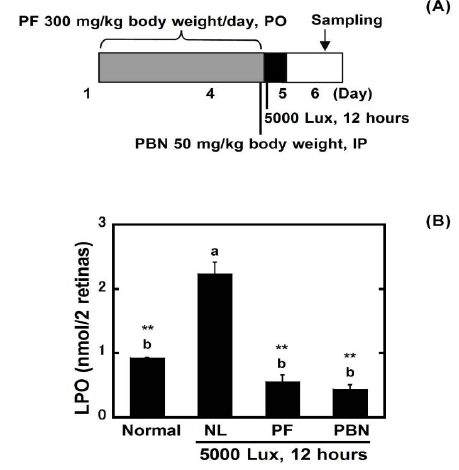
Figure 5. Inhibition of light-induced retinal lipid peroxidation. ( A ) Experimental design. The rats received oral PF (300 mg/kg of body weight/day) once daily for four days. PBN (50 mg/kg body weight) was administered 30 min before light exposure by intraperitoneal injection. On the fourth day, the rats were exposed to intense light (5000 lux) for 12 h, after which they were returned to the dim cyclic light conditions. The eyes were enucleated 24 h after light exposure. PO indicates per os; ( B ) The result of the lipid hydroperoxide (LPO) assay. Data represent the mean ± SEM ( n = 4). These data show the results of analysis by Tukey’s method and Dunnett’s method. Alphabets (a and b) indicate values that differ significantly between each group ( p < 0.05) tested by Tukey’s method. Asterisks indicate values that differ significantly to negative control tested by Dunnett’s method (* p < 0.05, ** p < 0.01).